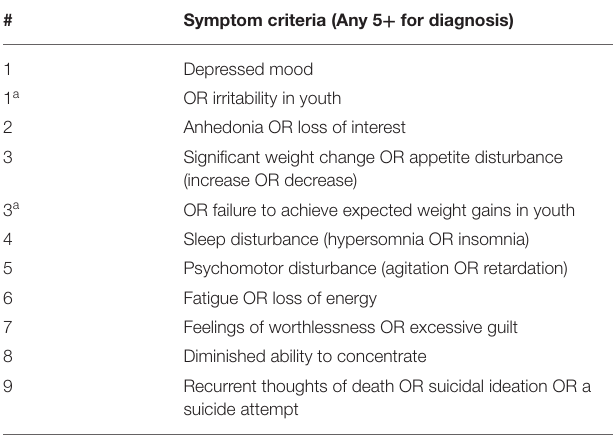
TABLE 1 | DSM-5 diagnostic criteria for major depressive